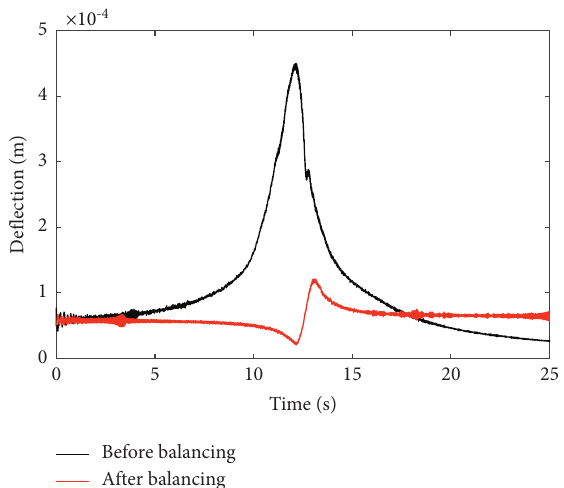
Figure 15: The transient deflection of the measuring point before and after balancing by the TCBM interface.